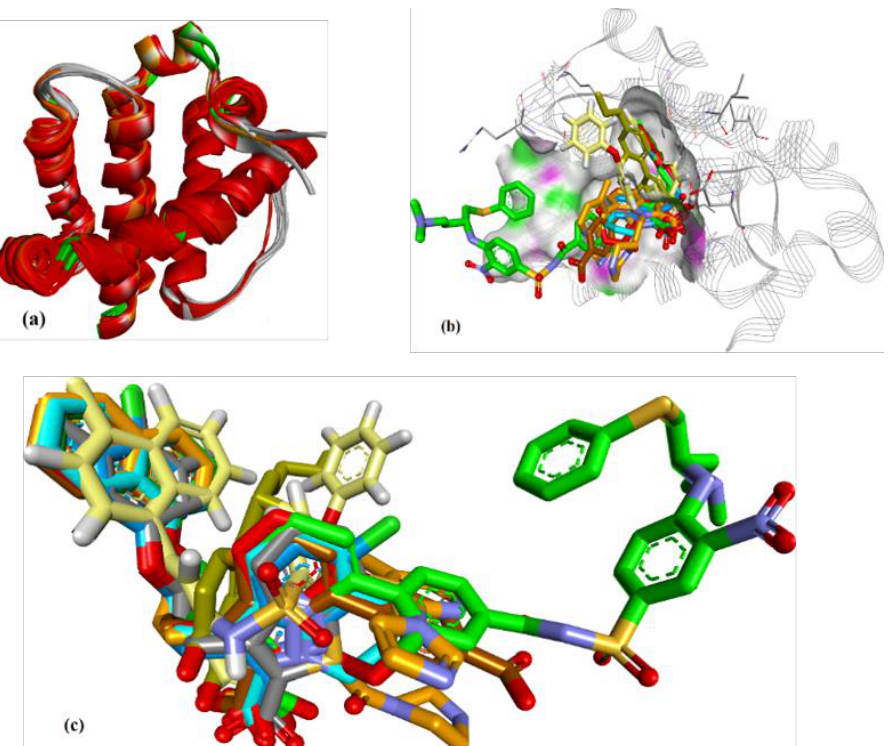
Figure 3. ( a ) Superposition of conformers of hMcl-1 found in crystal structures with small-molecule inhibitors. ( b ) H-donor and acceptor cavity in hMcl-1 identified by MLC (docking of ligands to 3WIX). ( c ) Superimposed binding poses of ligands obtained from co-crystal structures docked to 3WIX. Table 2. MRC approach: superposition of backbone of multiple hMcl-1 from various crystal struc- tures and their calculated RMSD values (Å ).